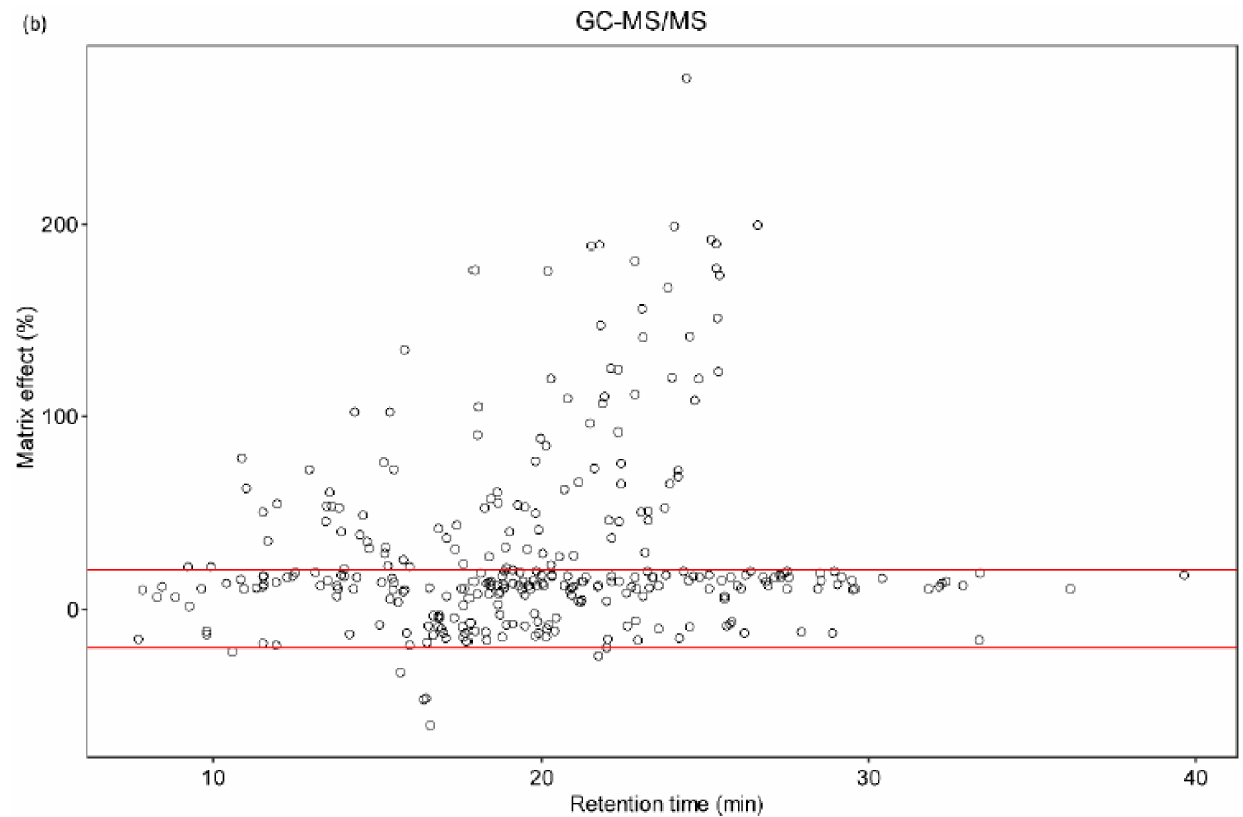
Figure 4. Correlation between retention time and matrix effect in ( a ) UPLC-MS/MS and ( b ) GC-MS/MS